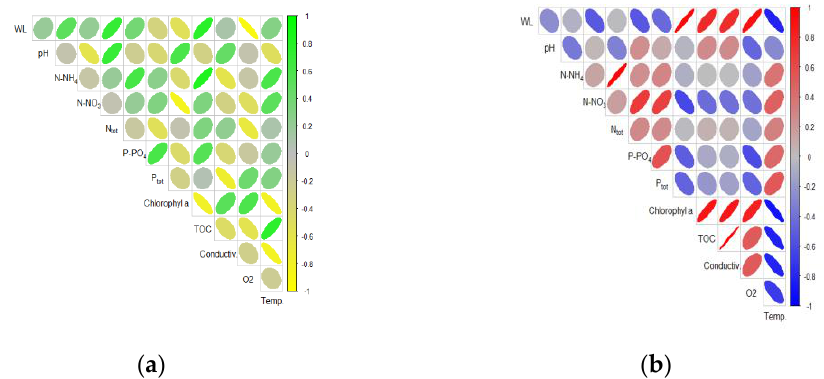
Figure 2. Correlogram between all related physical and chemical parameters before ( a ) and ( b ) after fire. The ellipse angulation and the colour intensity are proportional to the Pearson correlation coefficient: Positive correlations are drawn in green/red whereas the negative correlations are in yellow/blue.